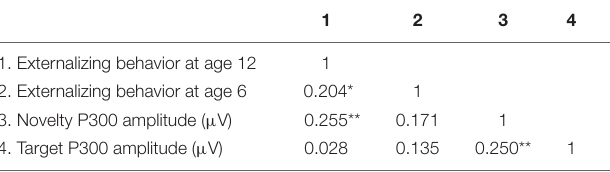
TABLE 3 | Pearson correlations between ERP and behavior problem.